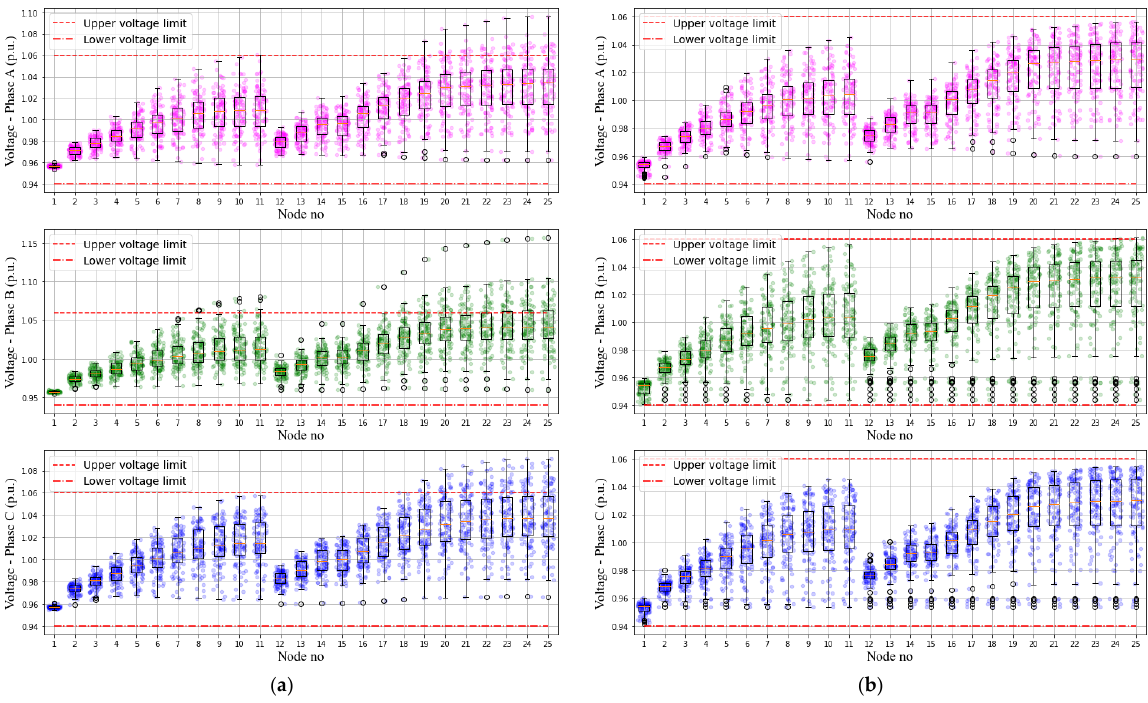
Figure 4. Variation of nodal voltages of the LVDN for ( a ) without VC and ( b ) with VC conditions for 100 Monte Carlo simulations — 200 kW.